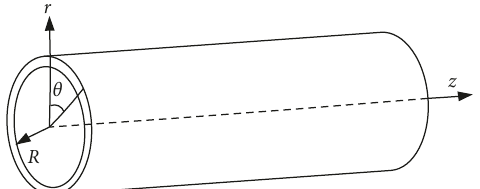
Figure 1: Hollow cylinder axes